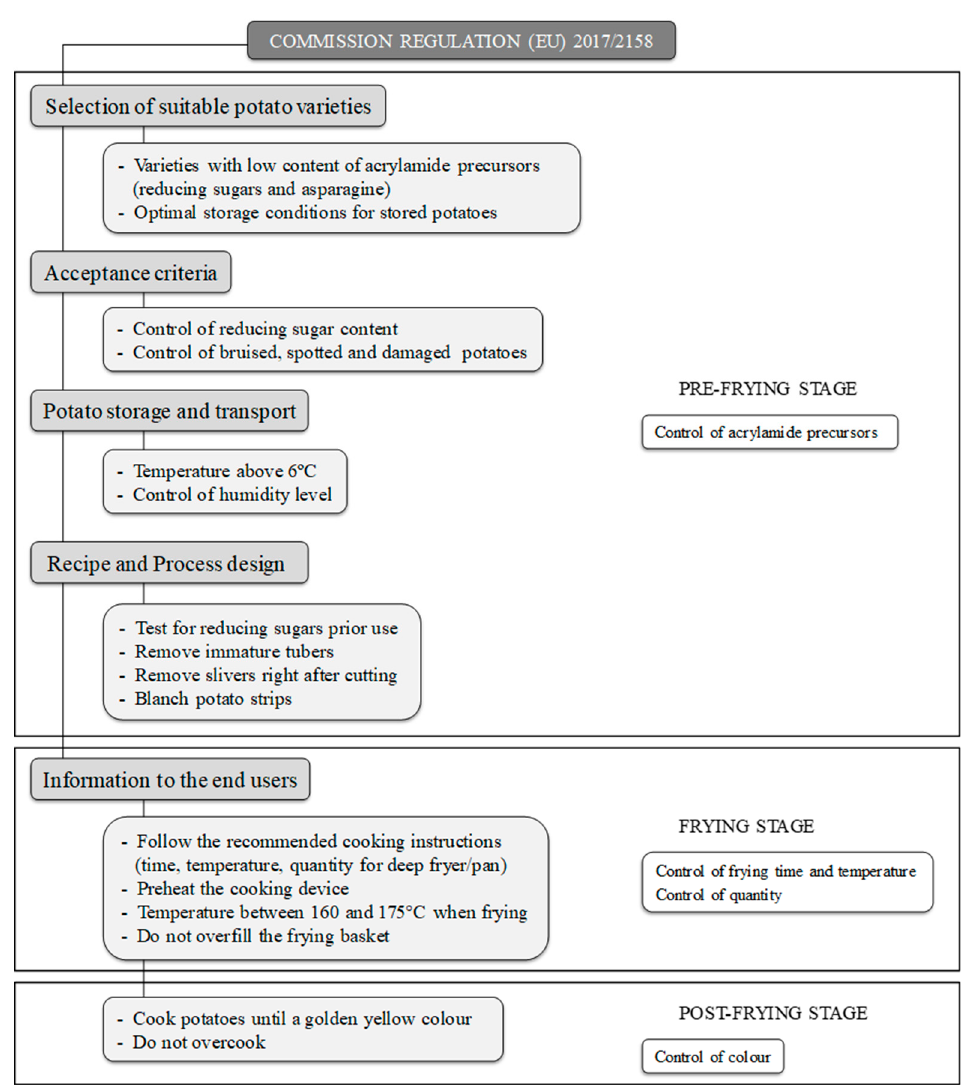
Figure 1. Mitigation measures referred to french fries made from raw potatoes according to the 2017/2158 Commission Regulation (EU) adapted for domestic habits.